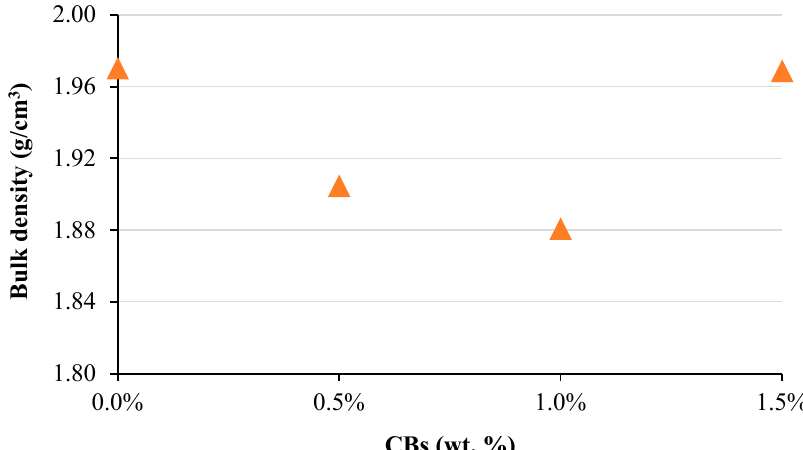
Figure 5. Water absorption versus CB% by mass.